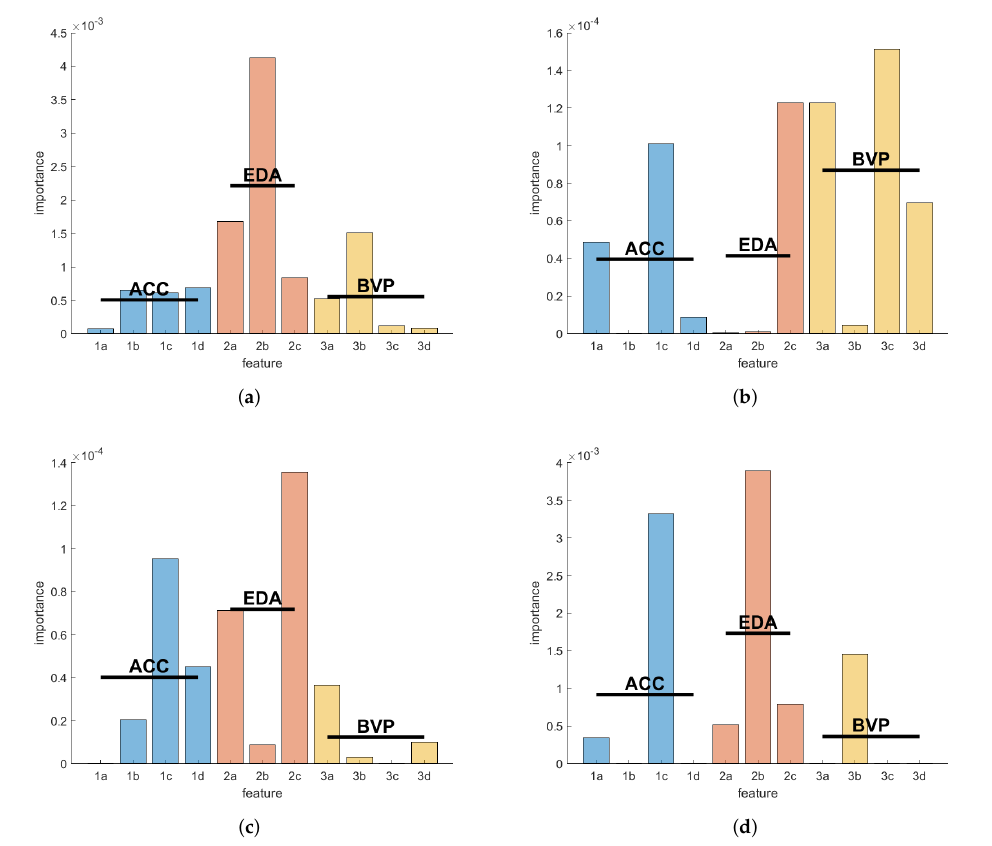
Figure 4. Feature importance scores per intra-subject evaluation for the seizure detection models of the three selected participants: ( a ) UKF1; ( b ) UKF2; ( c ) KCL1 (see Table A2); ( d ) Feature importance scores of the model resulting from training the GTBM model on the seizure data of all three inter- subject training participants. Blue, red, and yellow bars show the importance scores for the features grouped by biosignal modality ACC, EDA, and BVP, respectively. Horizontal lines mark the mean scores of the groups. The ordinate is unitless; the scores can be interpreted qualitatively. The feature labels correspond to the listing of features in the Materials and